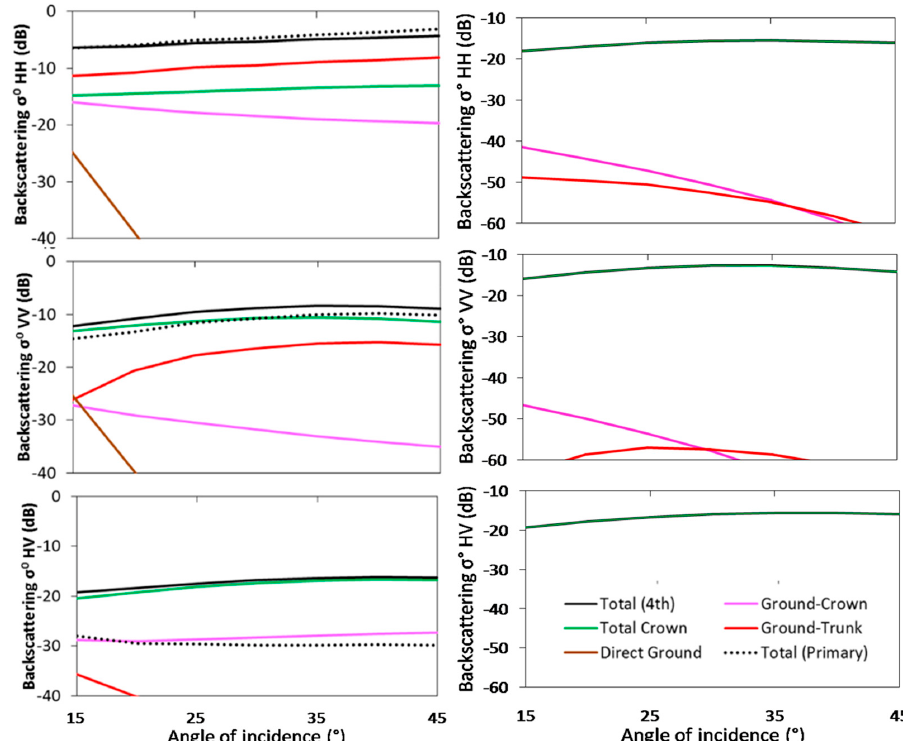
Figure 2. Total S-band co- and cross-polarised canopy backscatter components vs. scattering angle from 830 m − 3 leaves Betula pendula at fourth and primary branch levels from 6 m height and 7 m crown thickness ( left ) and 10,000 m − 3 needle and 3.4 m − 3 branch density from 8 m height 11 m crown thickness Norway spruce ( right ).